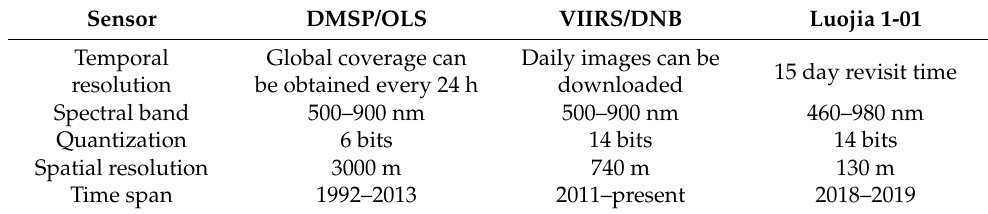
Table 1. Comparison of different NTL data.